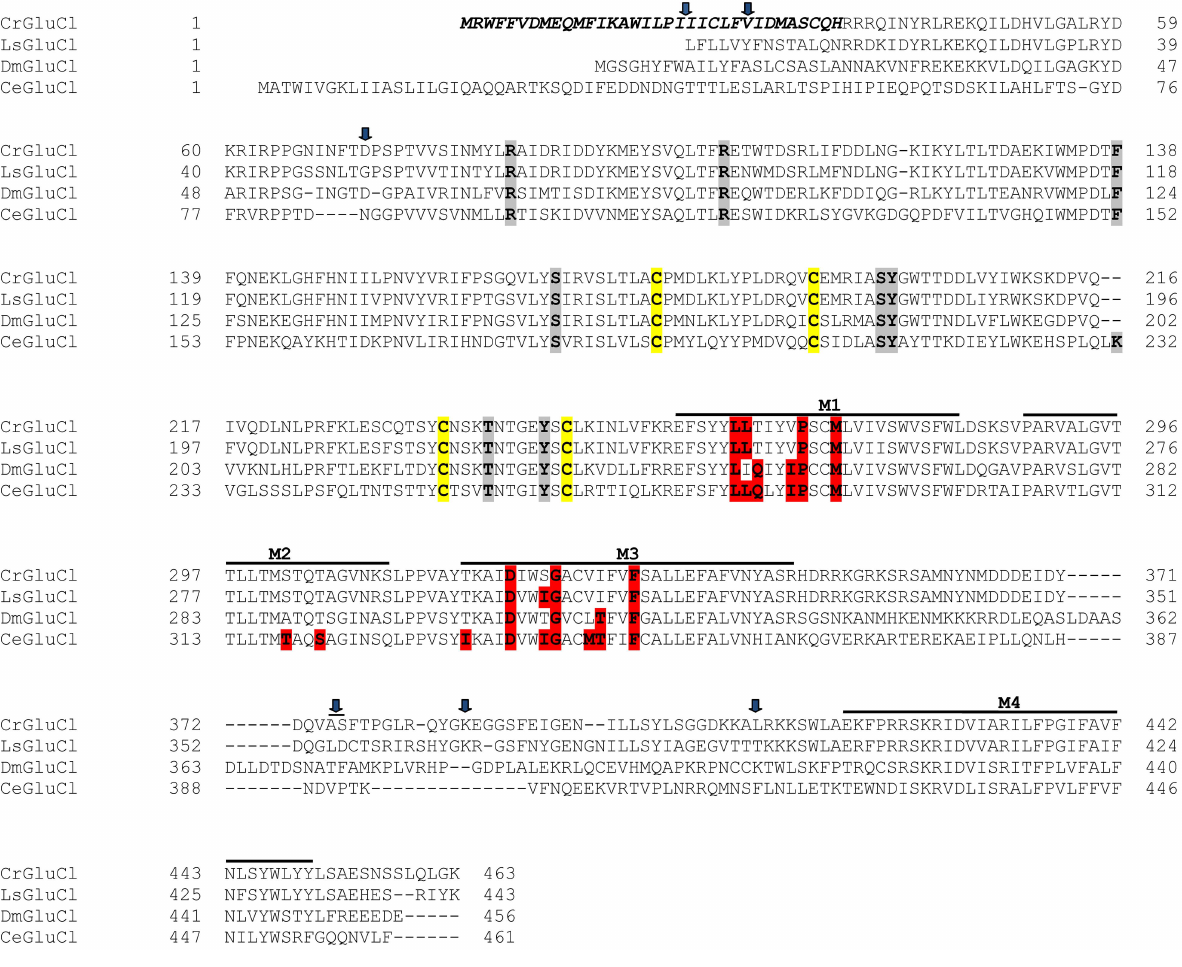
Figure 1. Alignment of CrGluCl a amino acid sequence with other glutamate-gated chloride channel a subunits. PROMALS3D program (http://prodata.swmed.edu/promals3d/) was used to generate an alignment with the following glutamate receptor GluCl a proteins: L. salmonis (Ls) GI:115361509, D. melanogaster (Dm) GI:1507685 and C. elegans (Ce) GI:559559. The predicted signal peptide of CrGluCl a , identified using SignalP 4.1 programme, is shown in bold italic. M1–M4 are transmembrane domains; cysteines involved in C-loops are highlighted in yellow; in grey and in red are residues involved in glutamate and ivermectin binding respectively. Arrows indicate amino acids variations between Caligus obtained from different sources (see Figure 2). The position of the transmembrane domains and binding sites is based on the crystal structure of the C. elegans GluCl a [16].